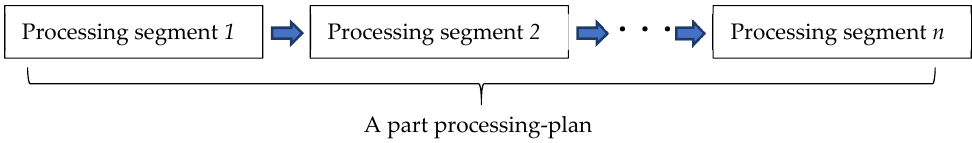
Figure 2. A part processing plan composed of several processing segments.